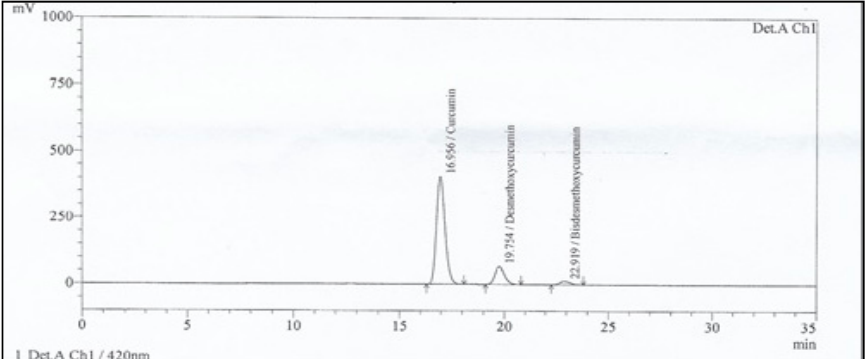
Figure 2. HPLC chromatograms of curcumin, desmethoxycurcumin (DMC), and bisdesmethoxycurcumin (BDMC) in a curcuminoid sample. The injection volume was 20 µ L and flow rate was 1.0 mL / min. Table 1. HPLC elution of the three compounds in the curcuminoid sample as well as the USP standard.